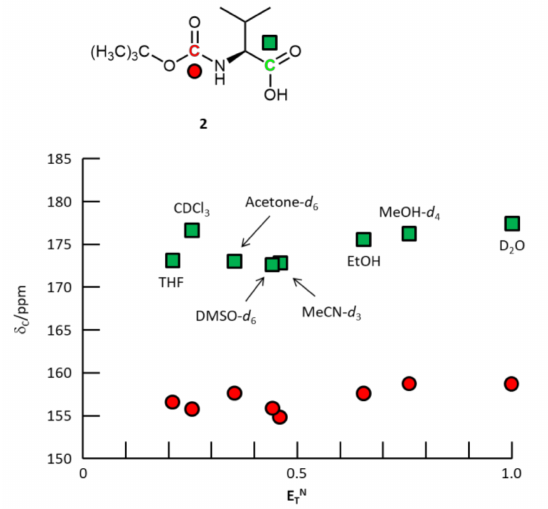
Figure 2. 13 C NMR chemical shifts of the carbonyl carbons of N -Boc-L-valine-OH 2 .